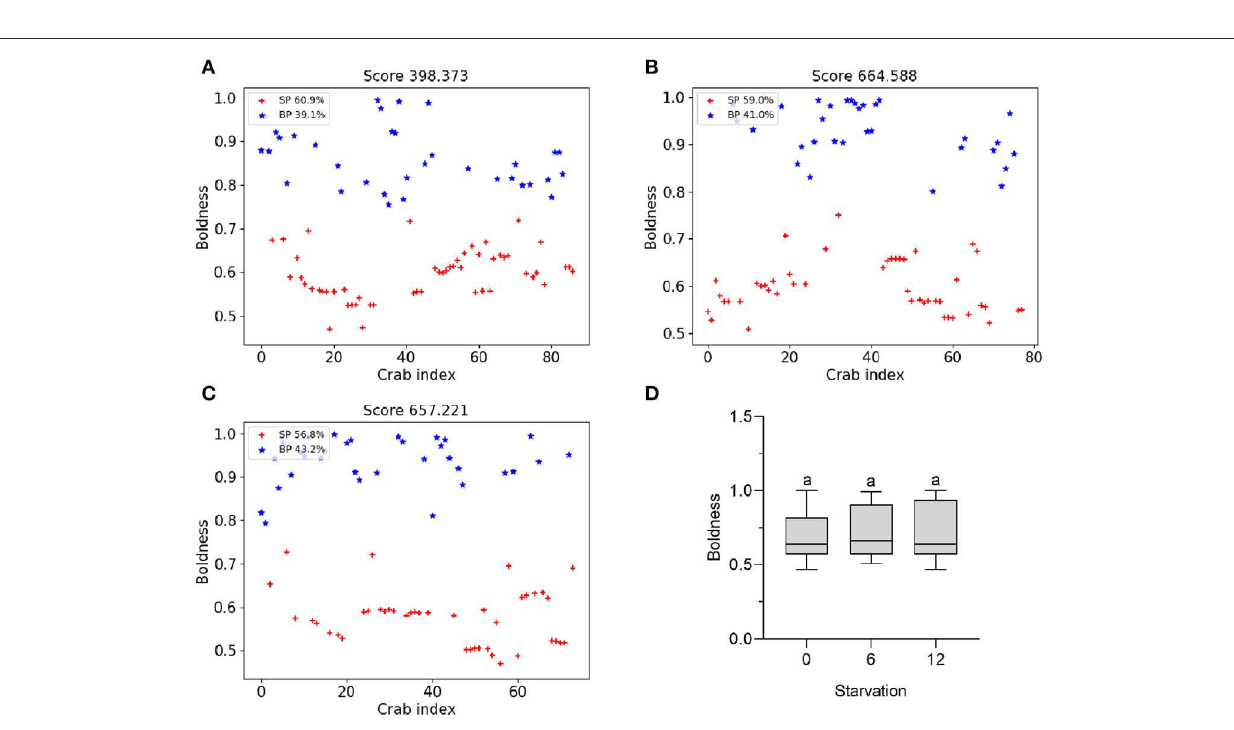
Frontiers in Marine Science | www.frontiersin.org